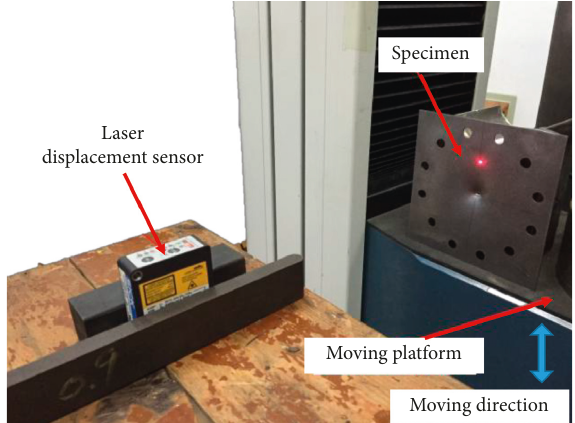
Figure 9: Deformation measurement